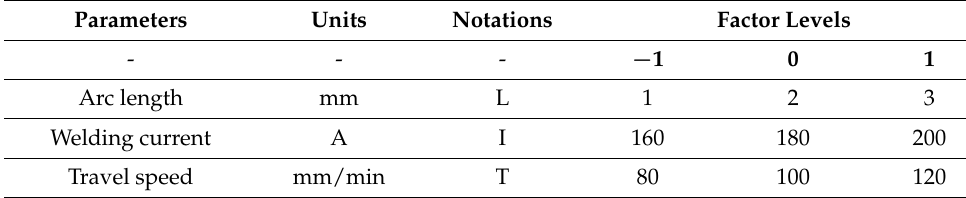
Table 3. Welding parameters and their levels